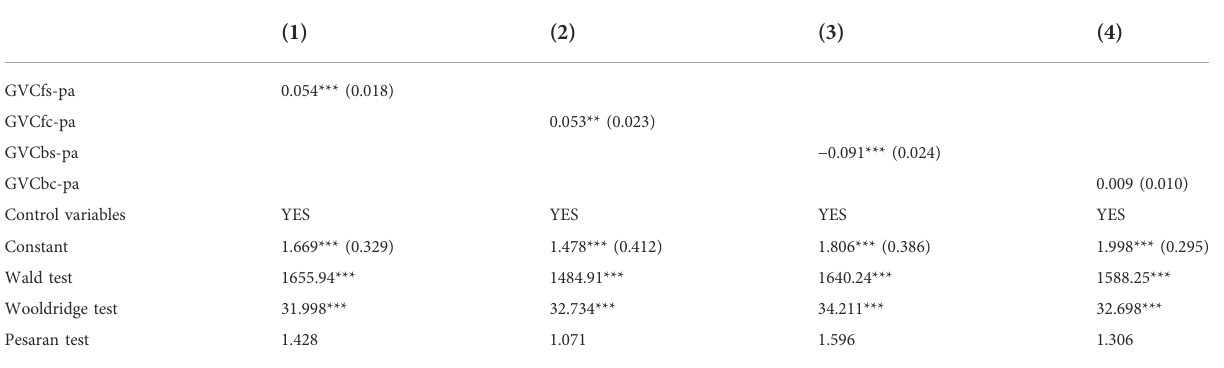
TABLE 5 Heterogeneity analysis (a).